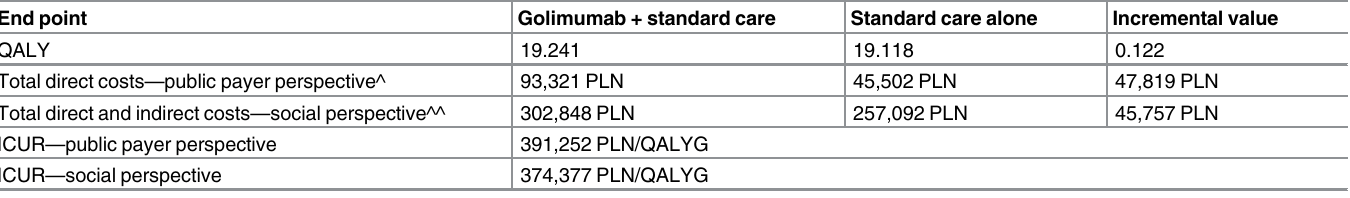
Table 3. Base-case